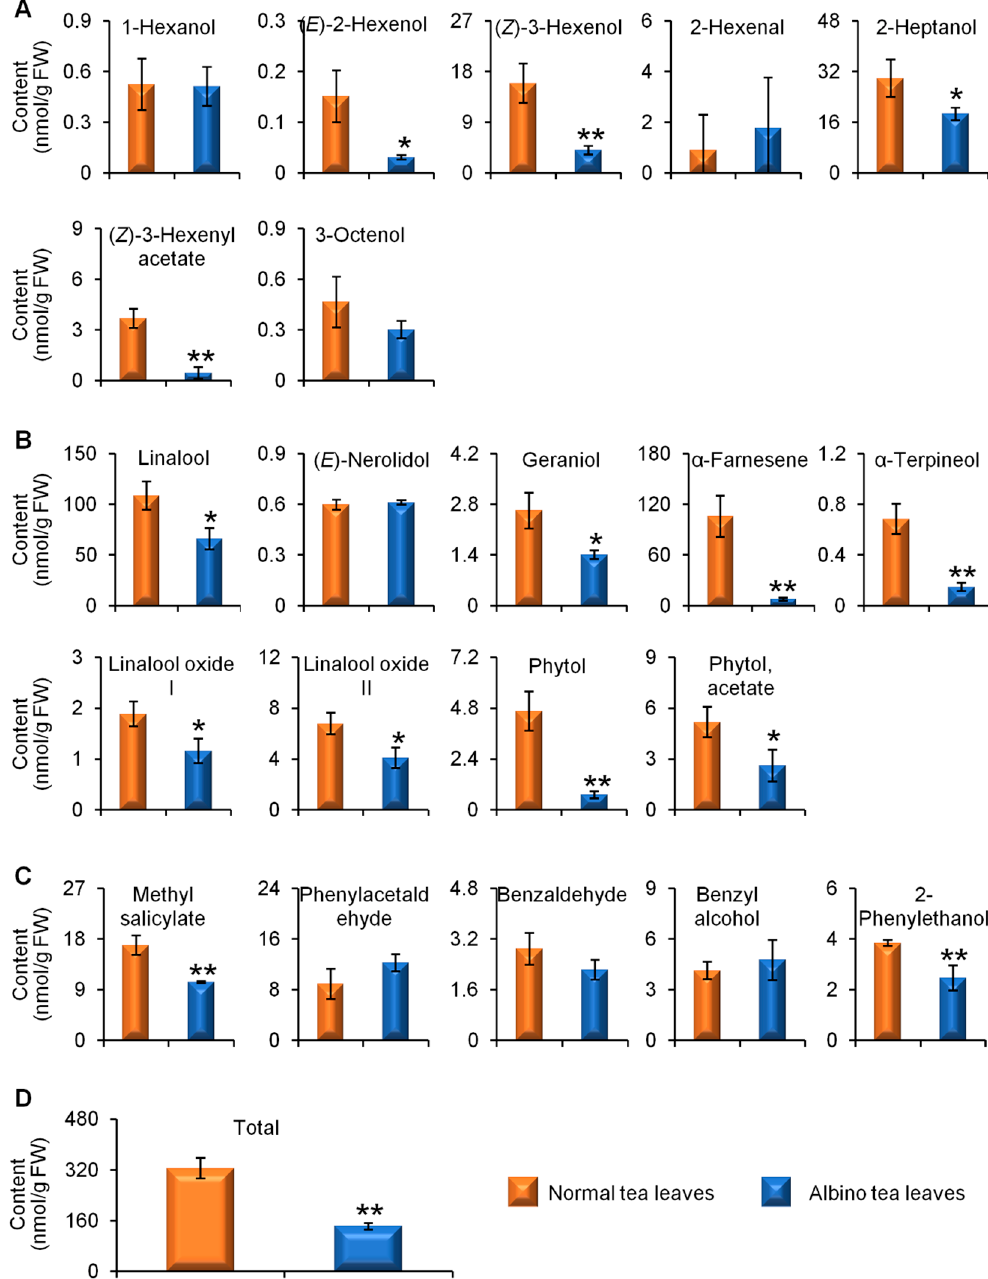
Figure 3. Differential accumulation of aroma compounds in normal green and albino-induced yellow tea ( Camellia sinensis ) leaves (cv. Yinghong No. 9) collected in December. ( A ) aroma fatty acid derivatives; ( B ) aroma terpenes; ( C ) aroma phenylpropanoids/benzenoids; ( D ) total content of aroma